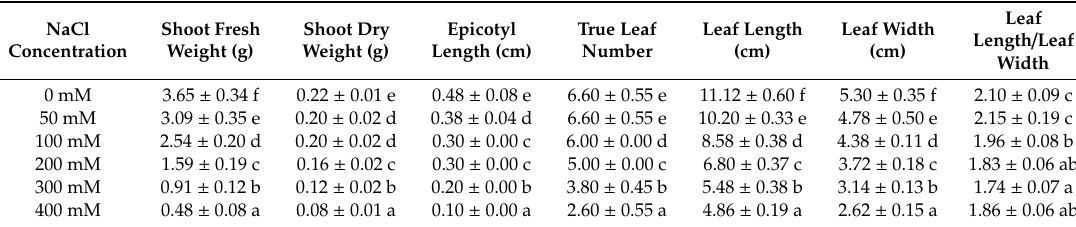
Figure 1. Changes in visual appearance of lettuce seedlings grown under di ff erent NaCl concentrations during the progressive treatment schedule. Table 2. Growth parameters of lettuce seedling as a ff ected by di ff erent NaCl concentrations at eight days after the experiment.